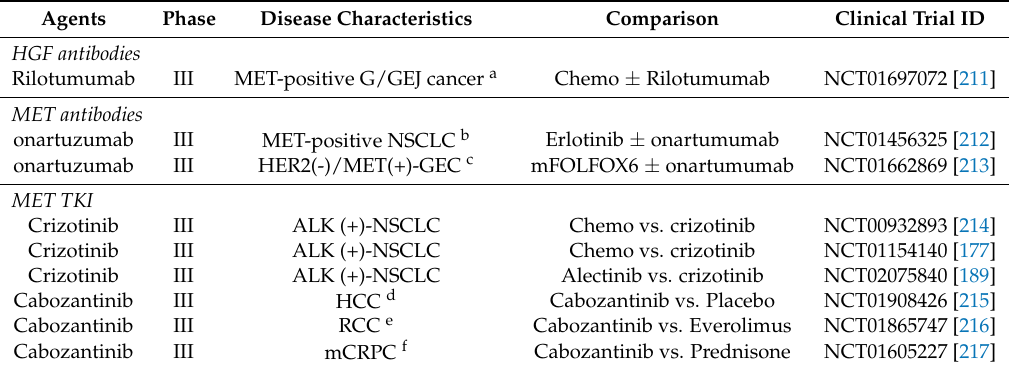
Table 5. Published phase III studies of MET